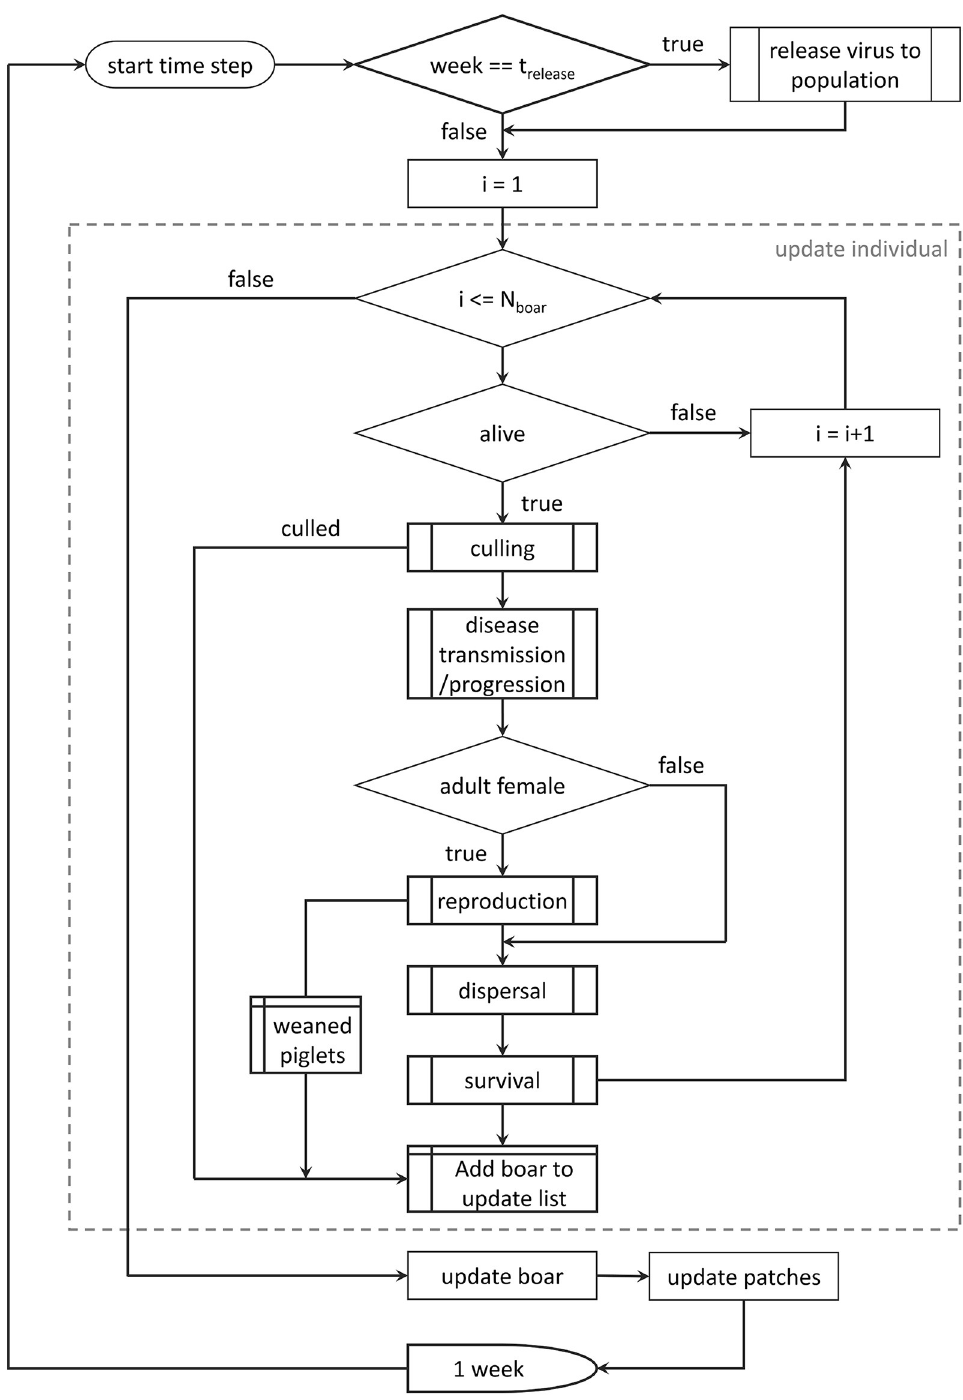
Fig 2. Model diagram. Flow chart outlining the updating process applied in the model.